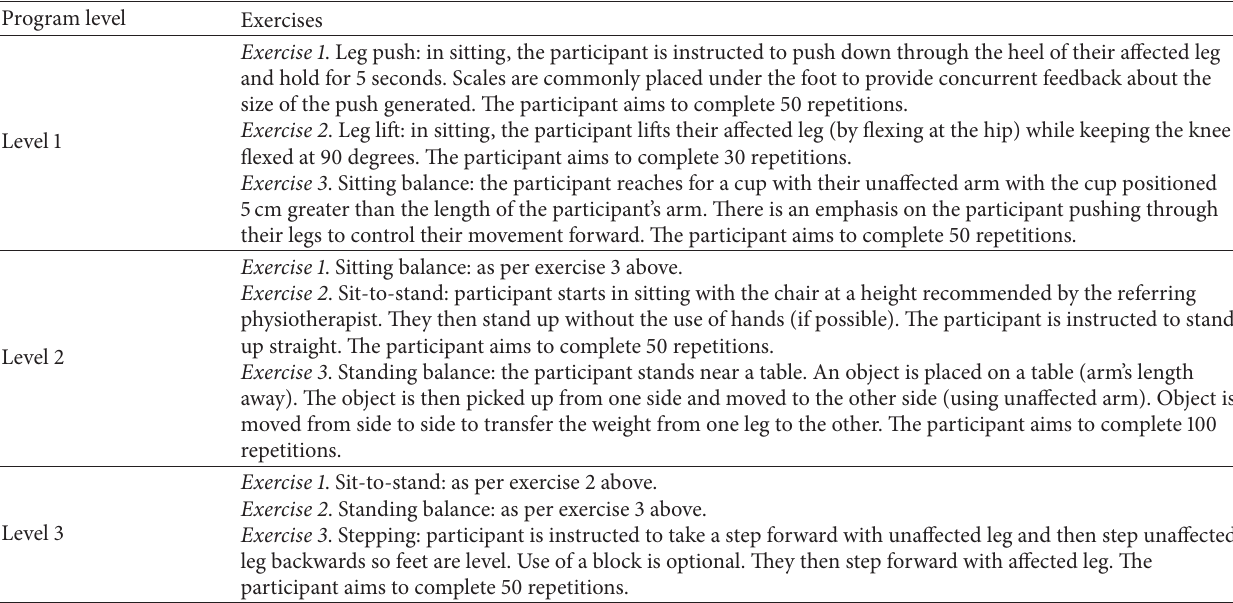
Table 1: Details of the Weekend Warrior exercise